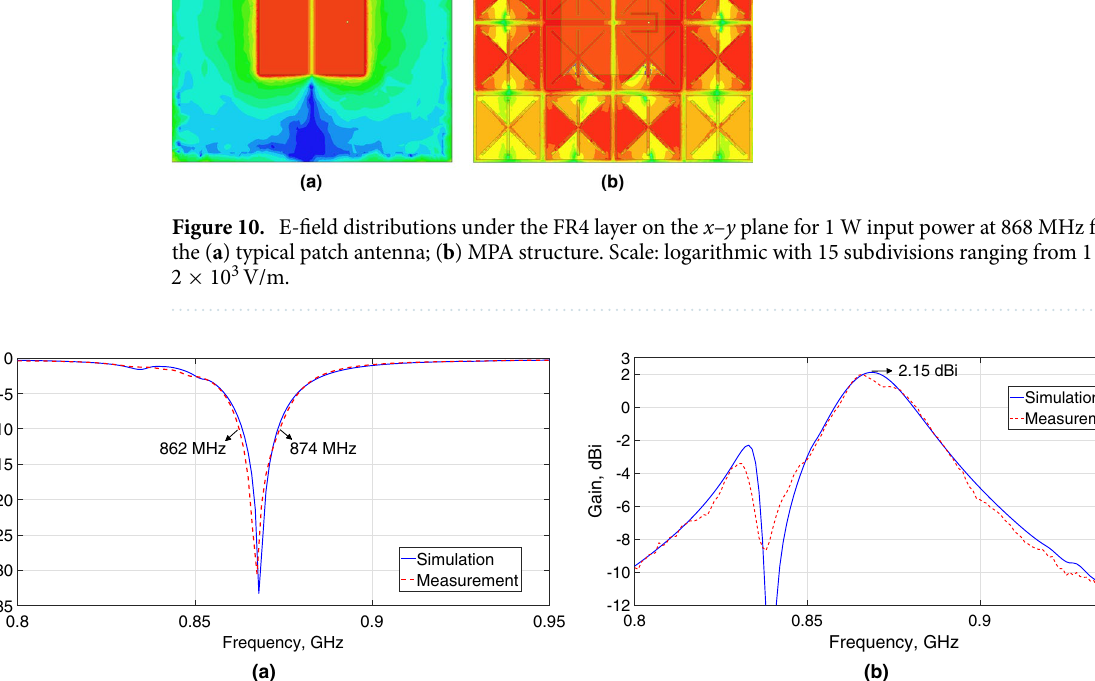
Figure 11. Measured and simulated ( a )